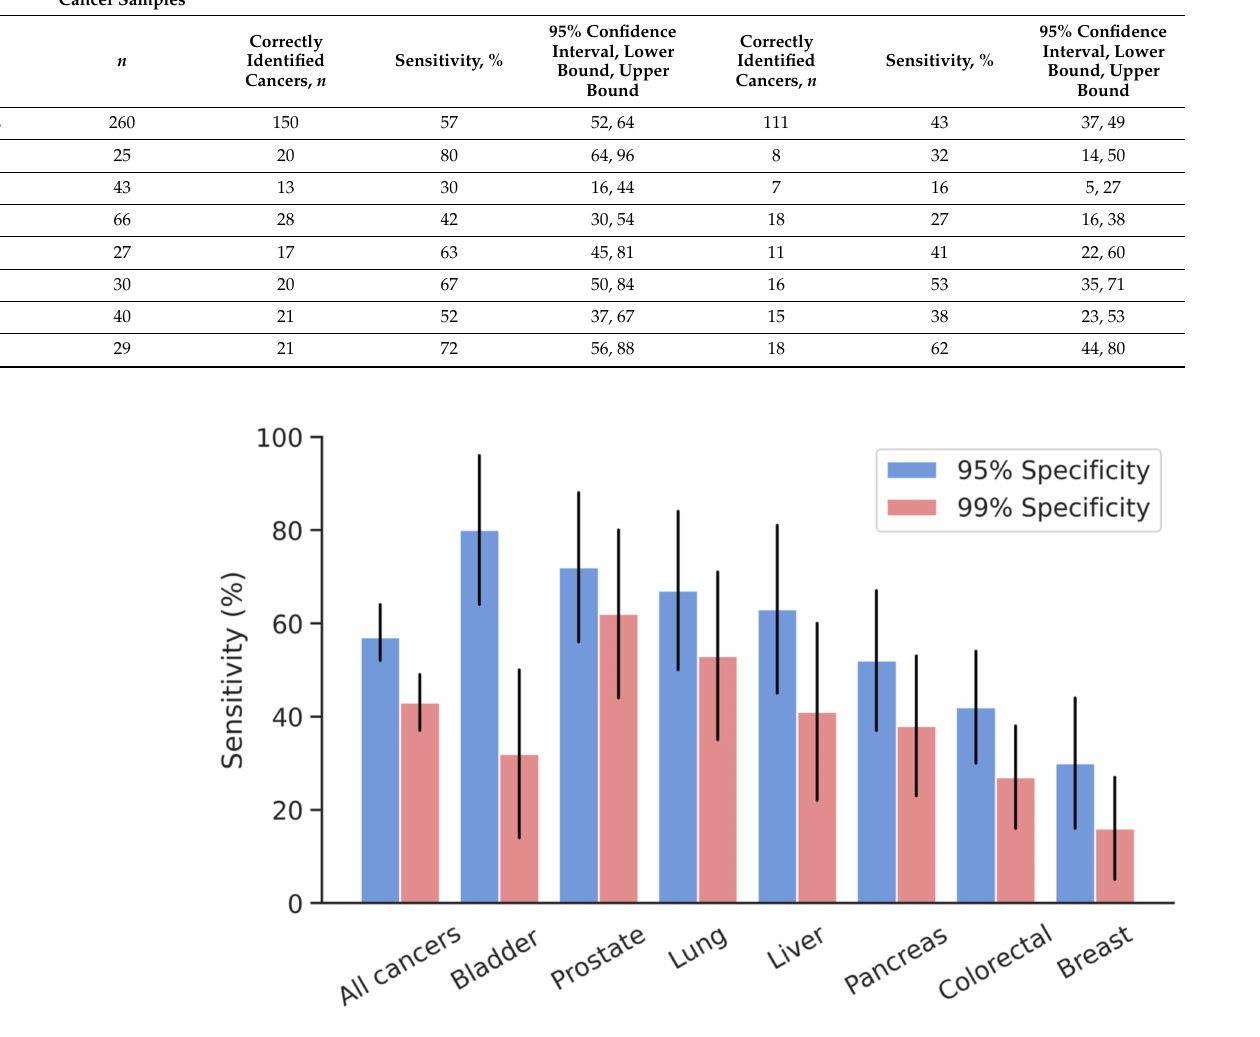
Figure 2. Sensitivity of DEEPGEN TM platform by model at 99% and 95%